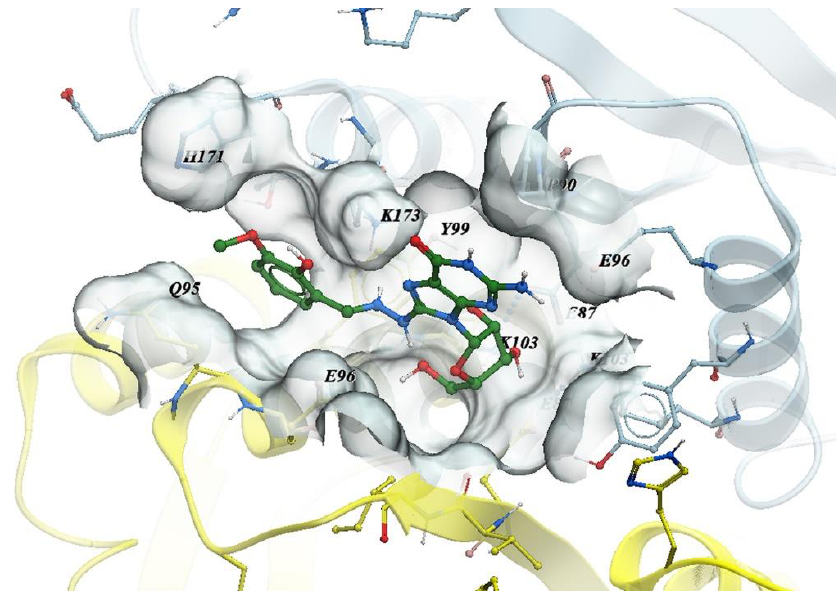
Figure 7. Binding mode of MCULE-2245265974 to HIV-1 integrase. The structure of two HIV-1 integrase monomers is shown in cartoon with chain A colored light cyan and chain B colored light yellow. Color coding of MCULE-2245265974: green carbon, red oxygen, blue nitrogen, gray hydrogen.